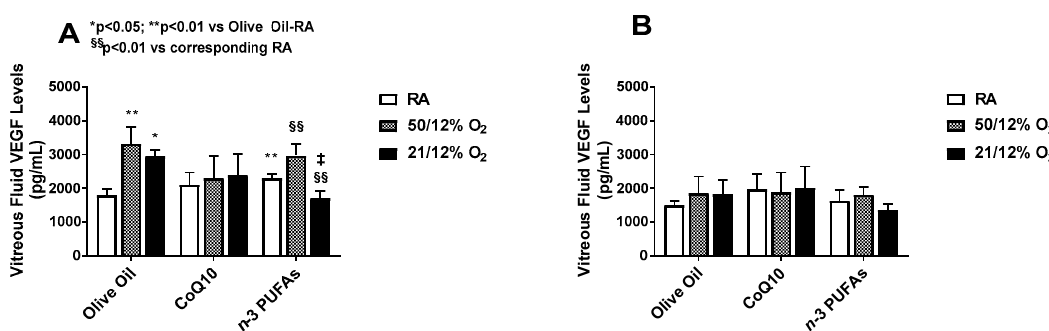
Figure 1. Effect of CoQ10 or n -3 PUFA supplementation in IH on vitreous fluid VEGF levels. Data are mean ± SD. n = six samples/group (* p < 0.05; ** p < 0.01 vs. olive oil in RA; ‡ p < 0.01 vs. olive oil in 21/12% O 2 ; and §§ p < 0.01 vs. corresponding treatment in RA). IH (intermittent hypoxia); RA (room air); VEGF (vascular endothelial growth factor).